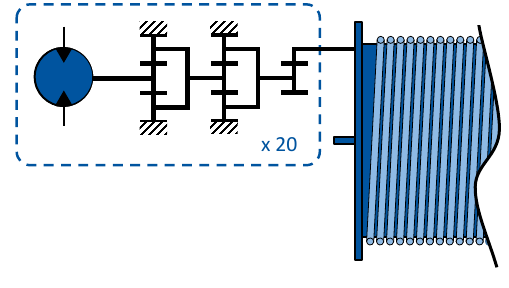
Figure 9: Schematic of the crane winch drivetrain